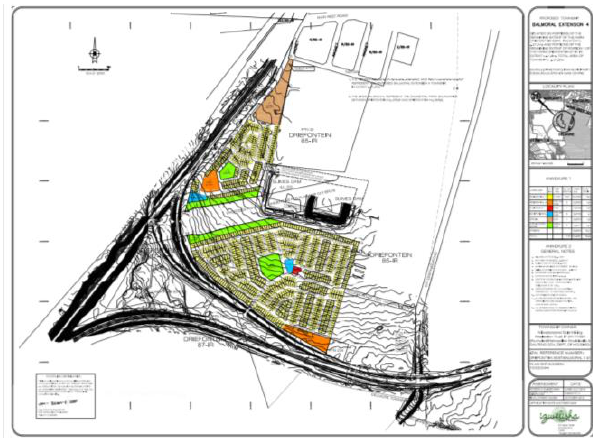
Figure 5: Balmoral Ext 4